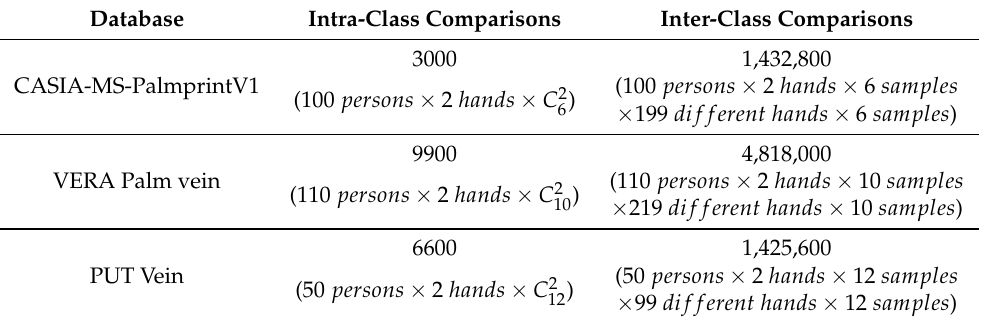
Table 3. Number of intra-class and inter-class matching pairs for the experiments in verification mode on each database.